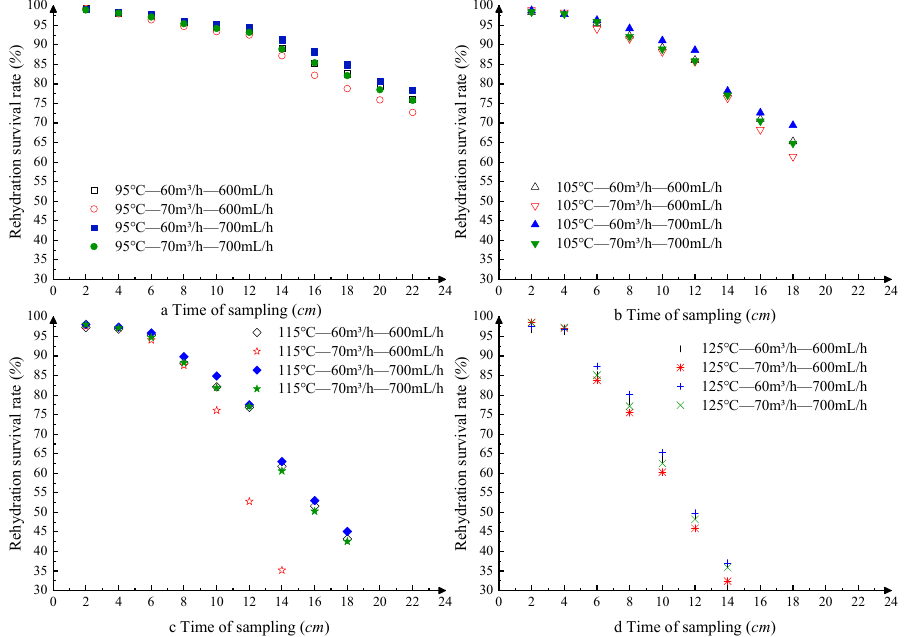
Figure 10. Rehydration survival rate of yeast under different test parameters with time. As shown in Figure 9 above, the moisture content of dry particles decreases with the increase of drying time at a constant rate first and then at a reduced rate. Combined with the analysis of Figures 7 and 9, yeast particles was not entirely top- down moving. Firstly, in group-c curve 2 and all curves in group-d, yeast particles move from top to bottom without reflux. Secondly, in all the curves except curve 2 in group-b and group-c, yeast particles refluxed from the sampling height of 90 cm to 75 cm, and then decreased along the tower wall. Finally, in all curves of group-a, the yeast particles re- fluxed from the sampling height of 90 cm to 60 cm, and then decreased along the tower wall. The motion track is shown in Figure 11.